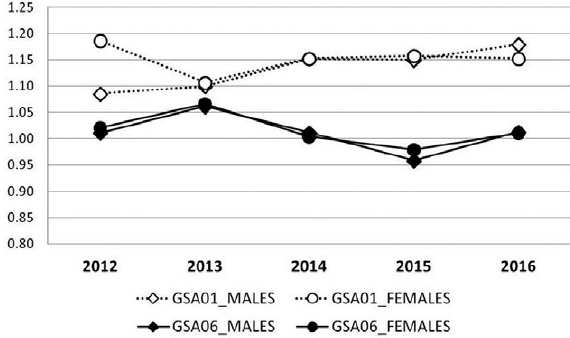
Fig. 8. – Time series of the annual anchovy body condition by sexes. The dotted line represents GSA01 and the continuous line represents GSA06. Males are symbolized by diamonds and females by